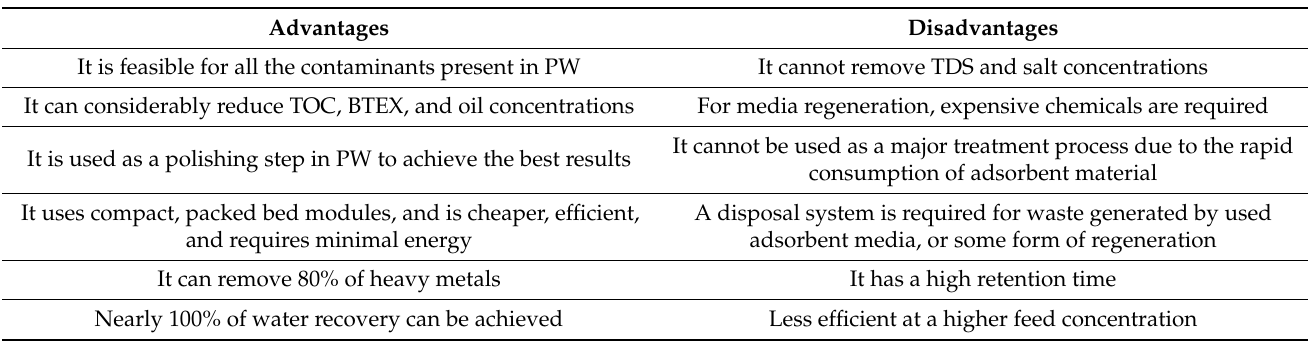
Table 5. Advantages and disadvantages of